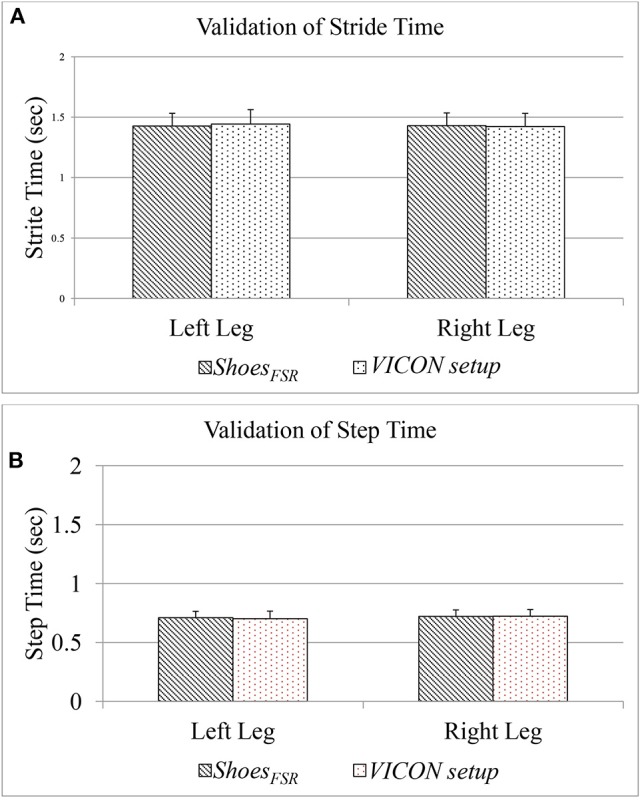
(A) Comparison of Stride Time measured using ShoesFSR and VICON setup; (B) Comparison of Step Time measured using ShoesFSR and VICON setup.